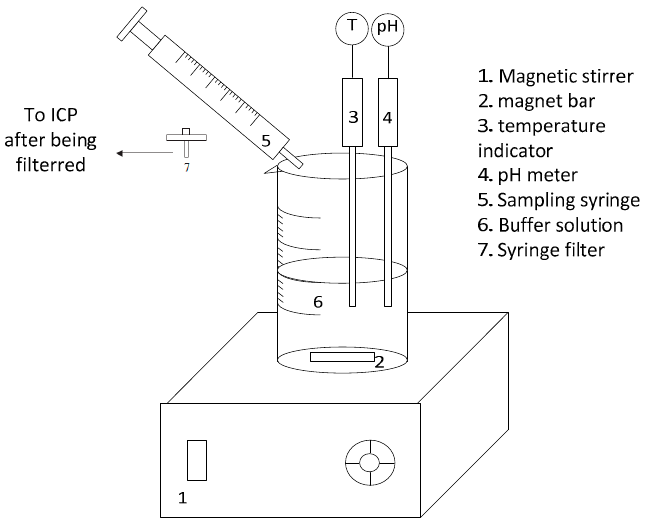
Figure 3. Schematic of the dissolution set-up [22] used to determine relative reactivity of raw, heat-activated, and heat-transformed dunite.